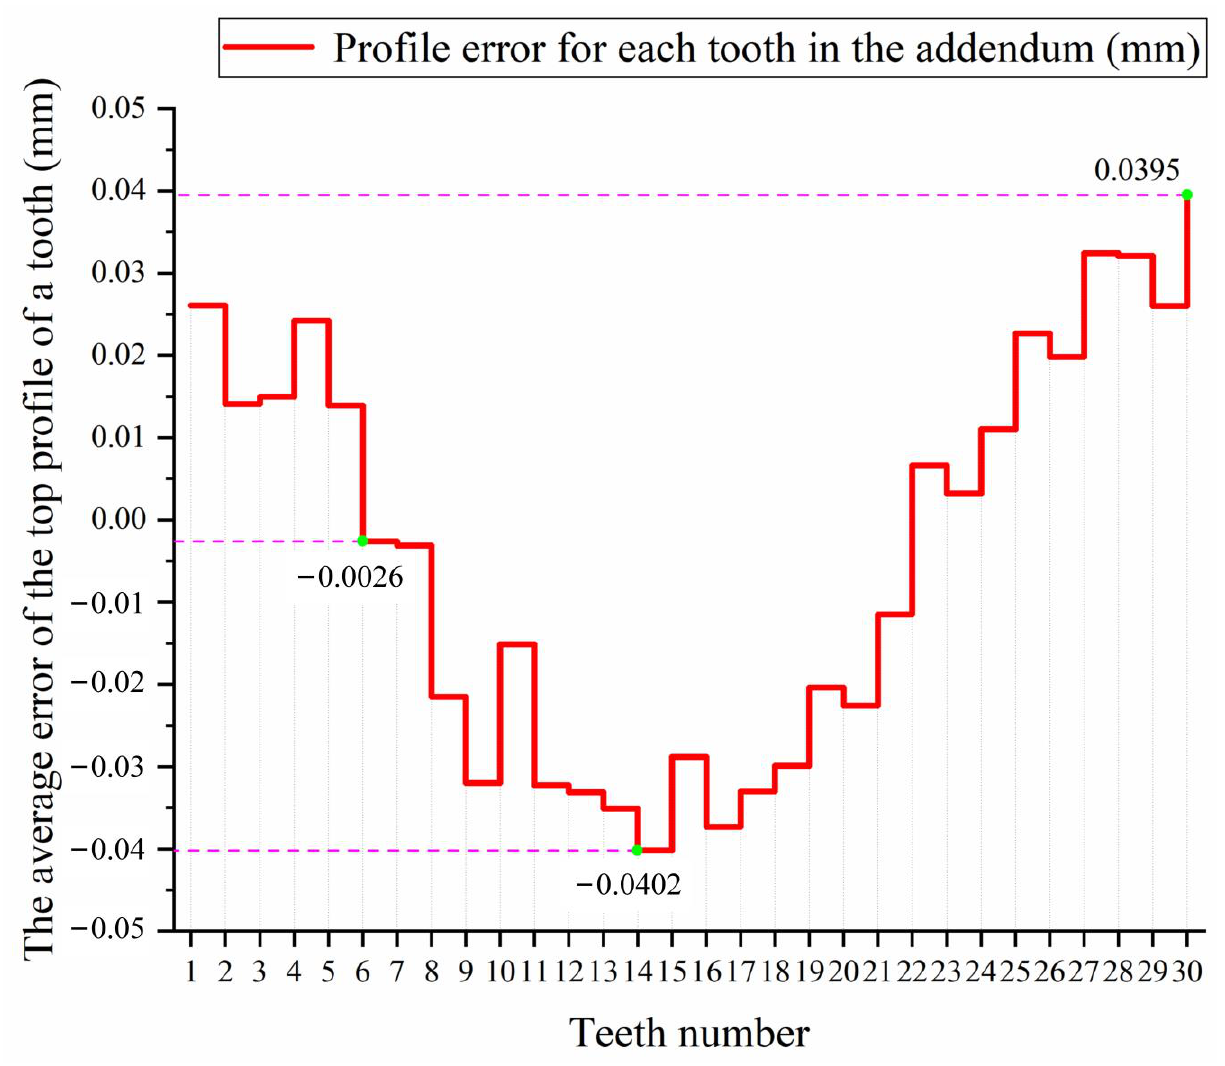
Figure 16. Error in the mean profile of each tooth surface.